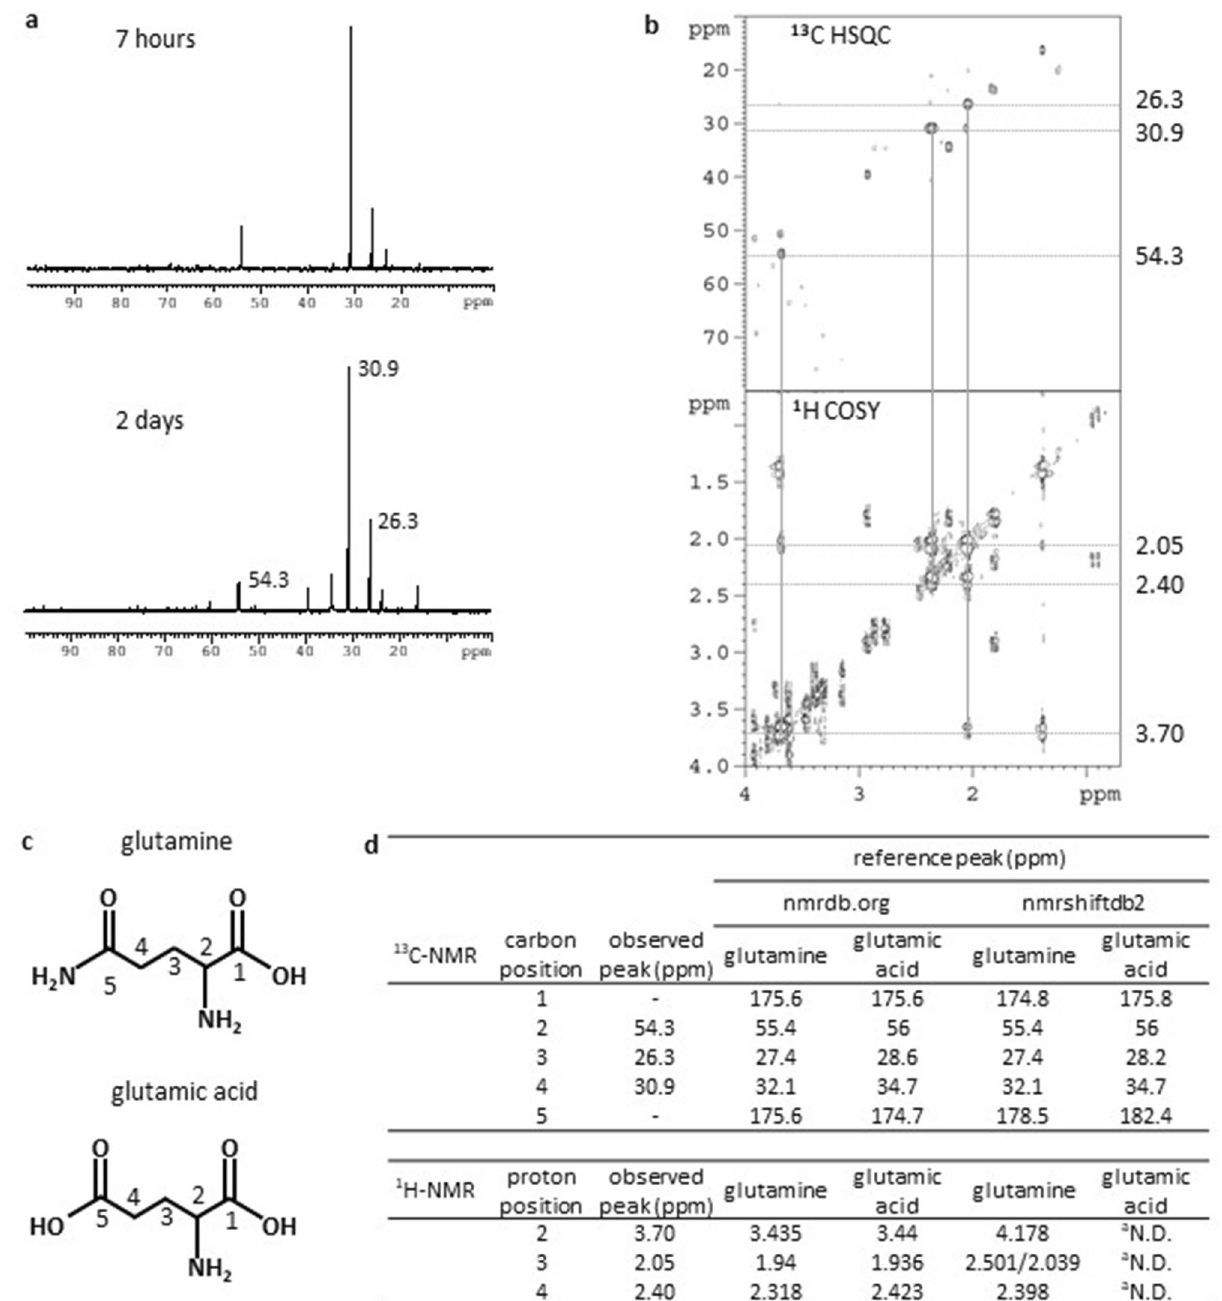
Figure 2. 13 C-NMR analysis of xylem sap in acetic acid-treated rice plants. ( a ) 13 C-NMR spectra of xylem sap. Two-week-old rice plants were treated with 30 mM methyl- 13 C-labeled acetic acid for 7 h or 2 days. Xylem sap was collected and analyzed by 13 C-NMR. Peaks in spectra observed in 13 C-labeled acetic-acid-treated xylem sap were subtracted from those of non-labeled acetic-acid-treated xylem sap and are shown. Chemical shifts of major peaks are indicated in ppm. ( b ) 2D 13 C-HSQC- 1 H-COSY spectra of xylem sap collected 2 days after acetic acid treatment. Chemical shifts of major peaks are shown in the right in ppm. ( c ) Structures of glutamine and glutamic acid. Positions of carbons assigned in ( d) are shown. ( d ) Summary of observed chemical shifts and reference data of glutamine and glutamic acid. Observed chemical shifts were assigned in nmrdb.org (https :// www.nmrdb .org/) and nmrshiftdb2 (https ://nmrsh iftdb .nmr.uni-koeln .de/). Reference data of chemical shifts in 13 C- and 1 H-NMR of glutamine and glutamic acid in the database are shown. a No data